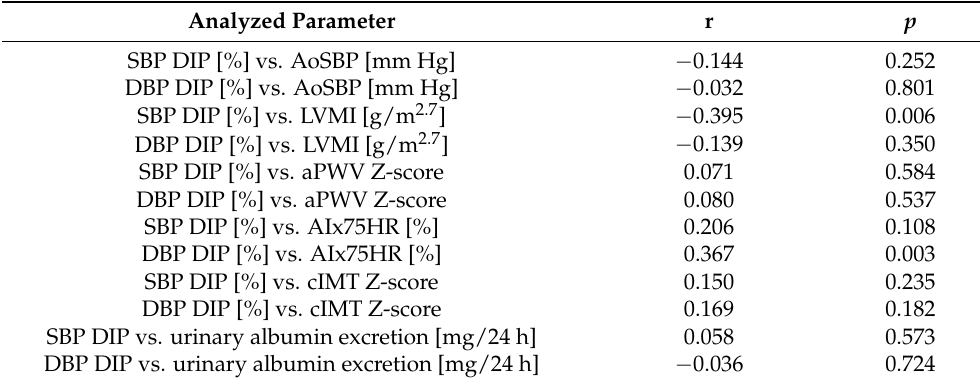
Table 6. Correlations of the parameters of hypertension-mediated organ damage with blood pressure dipping (continuous